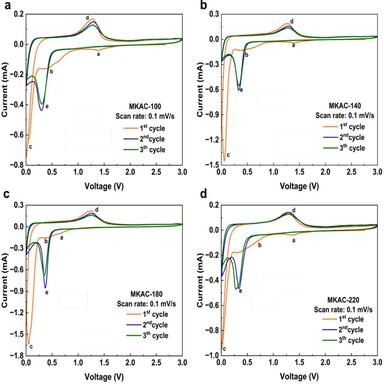
The first, second, and third CV curves of the MKAC-T anodes prepared by four different solvothermal temperature: (a) MKAC-100, (b) MKAC-140, (c) MKAC-180, (d) MKAC-220.